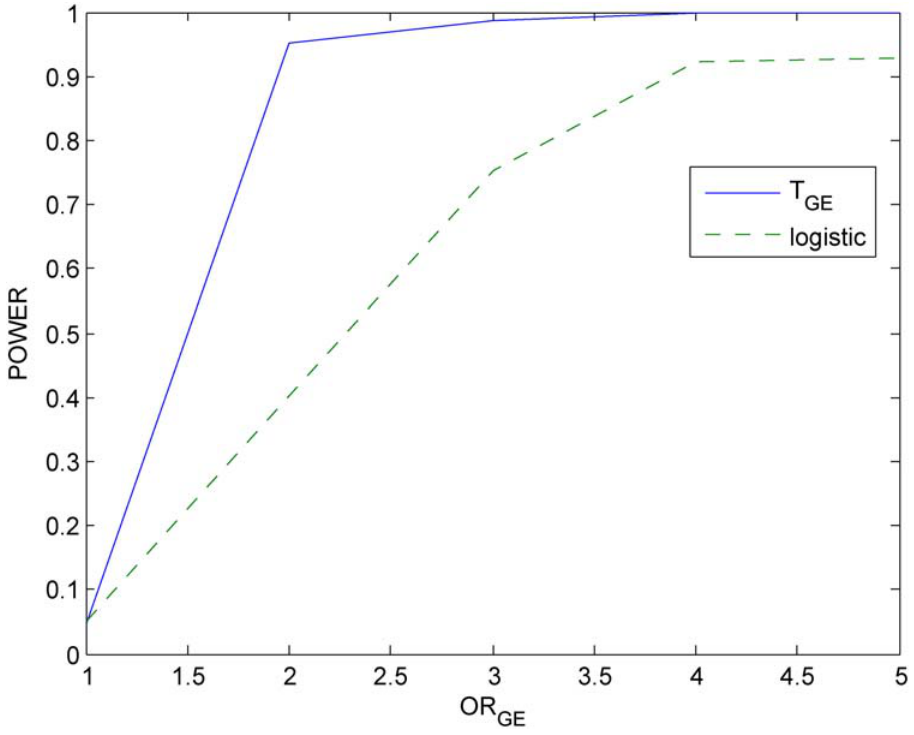
Figure 10. Power of the statistic T I and logistic regression analysis for sample size 500, OR G ~ 2 and OR E ~ 2 .